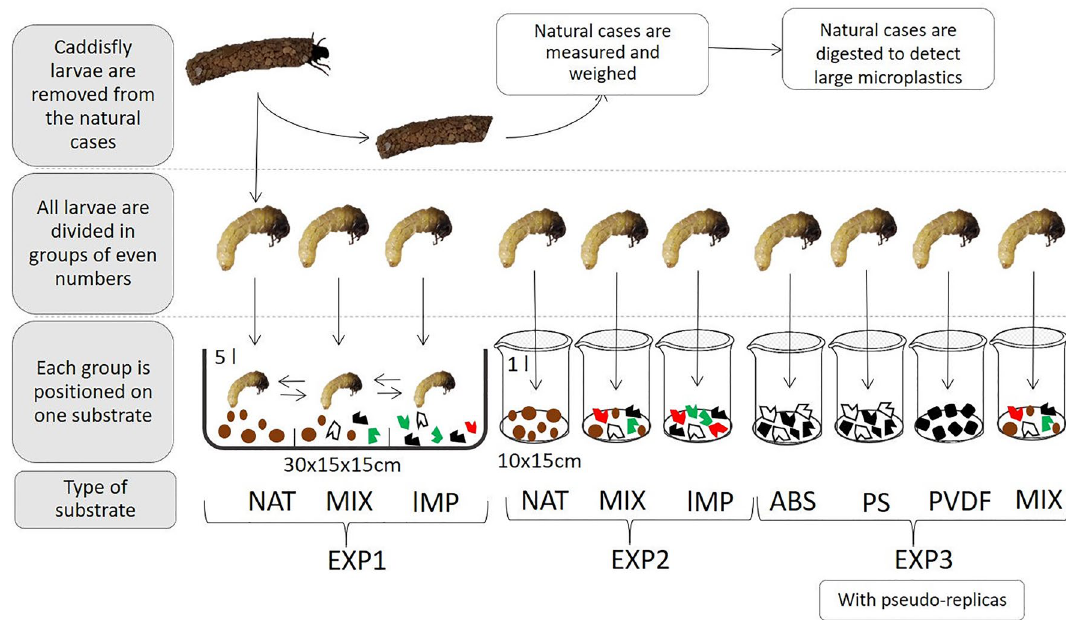
Figure 1. Scheme of the experiments 1 (EXP1), 2 (EXP2) and 3 (EXP3) conducted on caddisflies. The burrowing experiment of mayflies was carried out as EXP1 with the addition of pseudo-replicas. NAT: natural substrate of sand and river pebbles; lMP: mixture of PS, PET, PP (in equal proportions): MIX: mixture of NAT and lMP (50% each); ABS: acrylonitrile–butadiene–styrene; PS: polystyrene; PVDF: polyvinylidene fluoride. Measures of tanks: EXP1 = 30 × 15 × 15 cm (length × width × height), volume 5 l; EXP2 and EXP3 = 10 × 15 cm (diameter × height), volume 1 l. The image is obtained by the software PowerPoint (ver. 2002, https ://www.micro soft.com/it-it/micro soft-365/power point